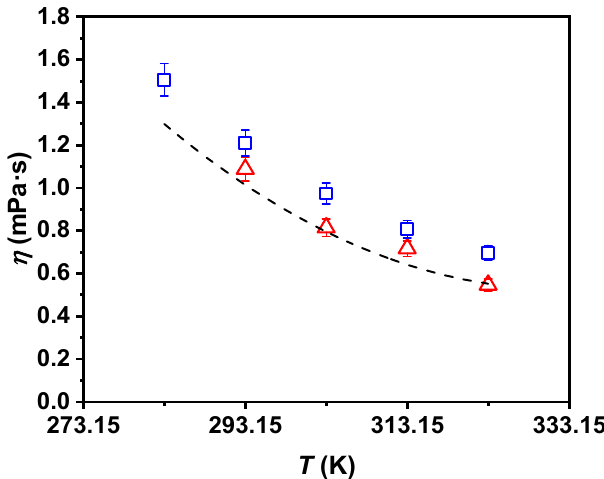
Figure 5. Experimental dynamic viscosity, η , of 0.50 wt% P-GnP/W nanofluid (UVigo laboratory, ☐ ; ILK laboratory, △ ) and ƞ of water (- - -) [55] as a function of temperature, T . Error bars indicate expanded uncertainty ( k = 2).